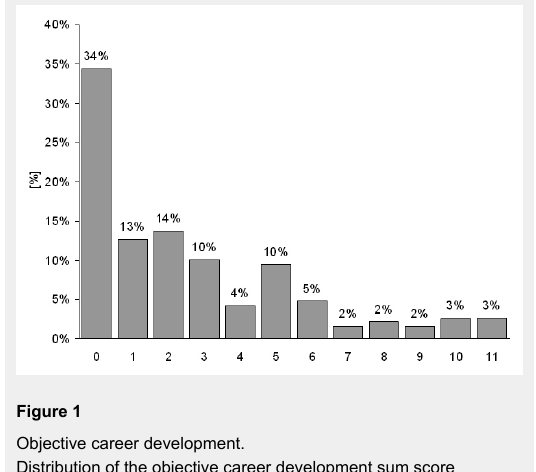
Objective career development. Distribution of the objective career development sum score (percentage of participants), defined on objective criteria for academic success (Career development sum score) with a range from 0 to